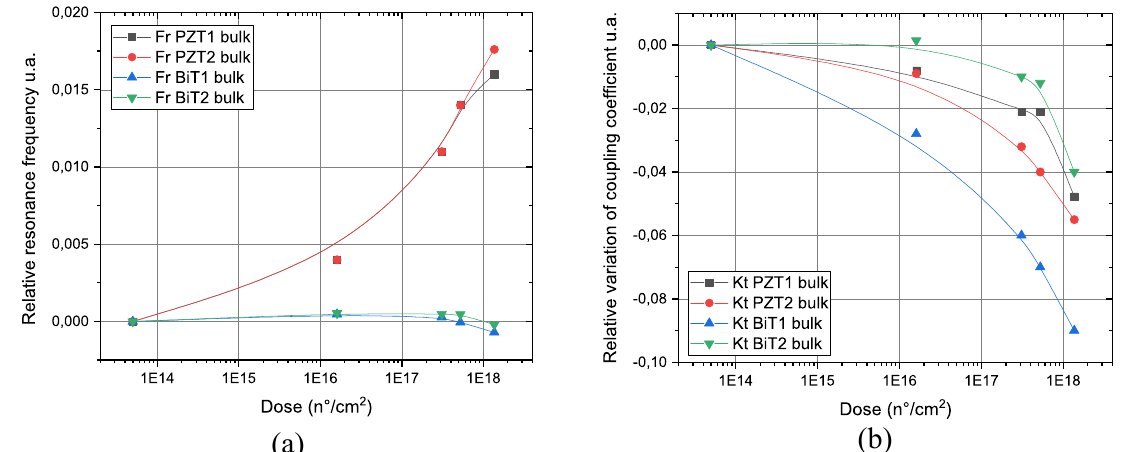
Fig. 9 : comparison between PT27 and PZ46. (a) relative variation of resonance frequency, (b) relative variation of electromechanical coupling.